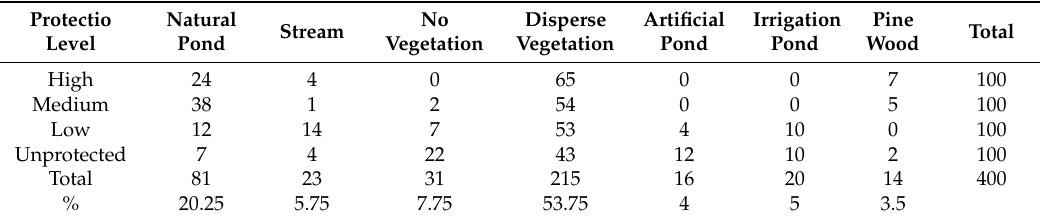
Table 2. Distribution of a random selection of 100 temporary water bodies from each protection level photo-interpreted into different types of water bodies.